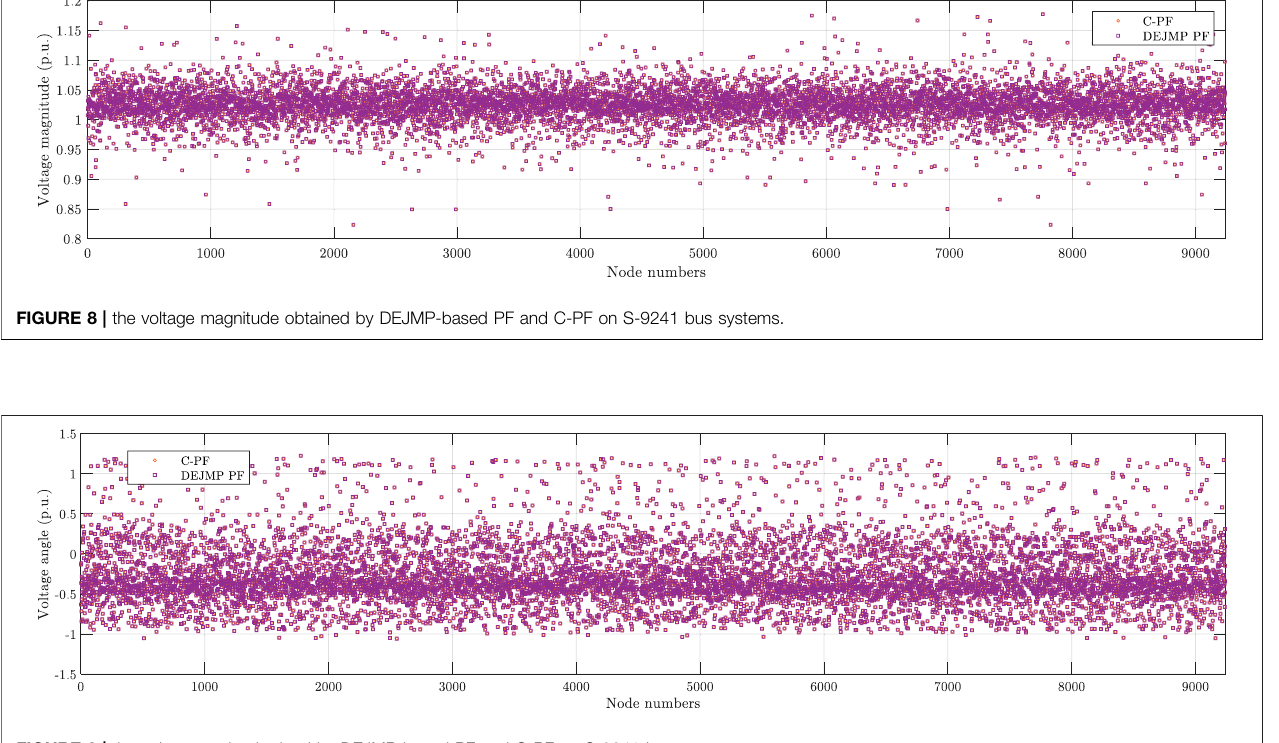
FIGURE 9 | the voltage angle obtained by DEJMP-based PF and C-PF on S-9241 bus systems.